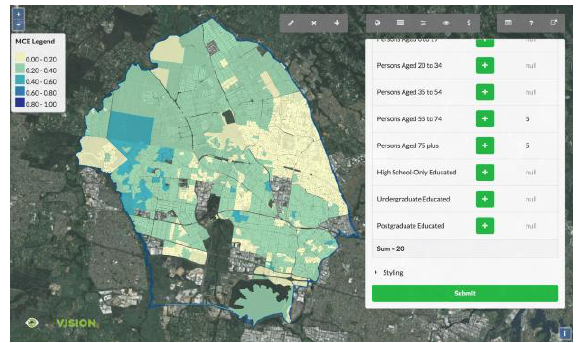
Figure 3. Envision MCE tool